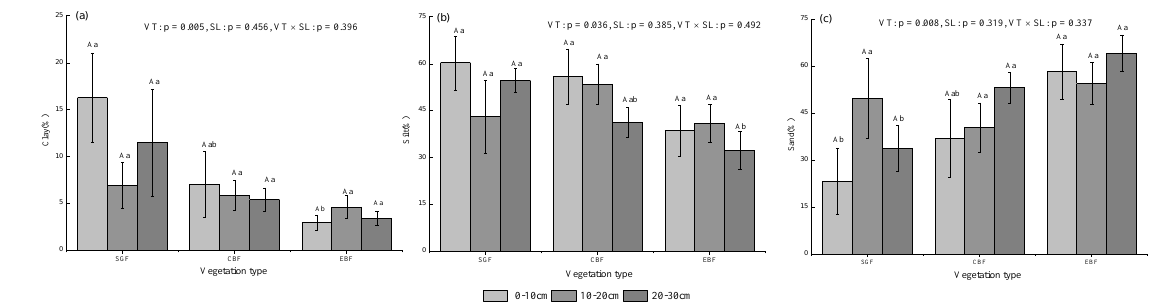
Figure 2. Soil particle composition of three vegetation types and three soil layers (mean ± SE, n = 4), SE is the variance of the index. The error line indicates standard error; upper case letters indicate a significant difference between different soil layers of the same land use types ( p < 0.05); the lower case letter indicates a significant difference among different land use types of the same soil layer ( p < 0.05). EBF stands for evergreen broad-leaved forest; CBF stands for mixed forest; SGF stands for shrub-grass forest; VT stands for vegetation type; SL stands for soil layer. Two-way ANOVA was applied to indicate significant differences between variances. ( a ) shows the Clay in different soil layers in different stands; ( b ) shows the Silt in different soil layers in different stands; ( c ) shows the Sand in different soil layers in different stands.